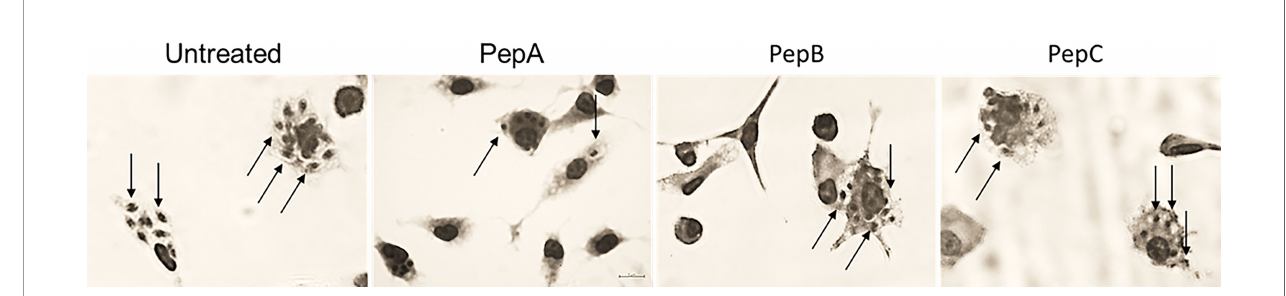
FIGURE 2 | Light microscopy images of peritoneal mouse macrophages pretreated with PepA, PepB, and PepC at 50 µM before infection with Trypanosoma cruzi . (A) Untreated, (B) PepA, (C) PepB, and (D) PepC. Arrows: intracellular parasites.